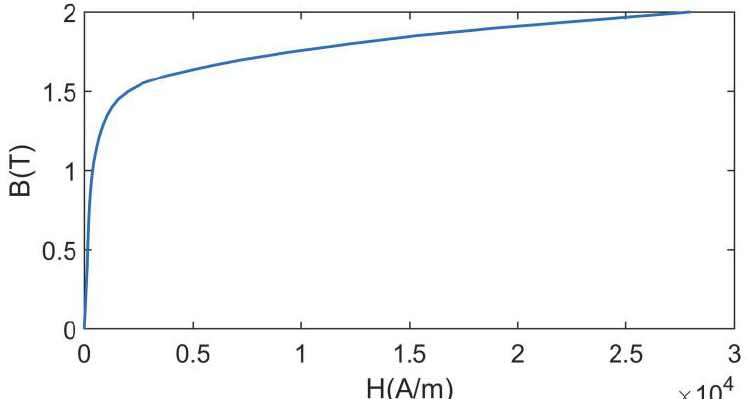
Figure 12. Hysteresis curve of the iron core.